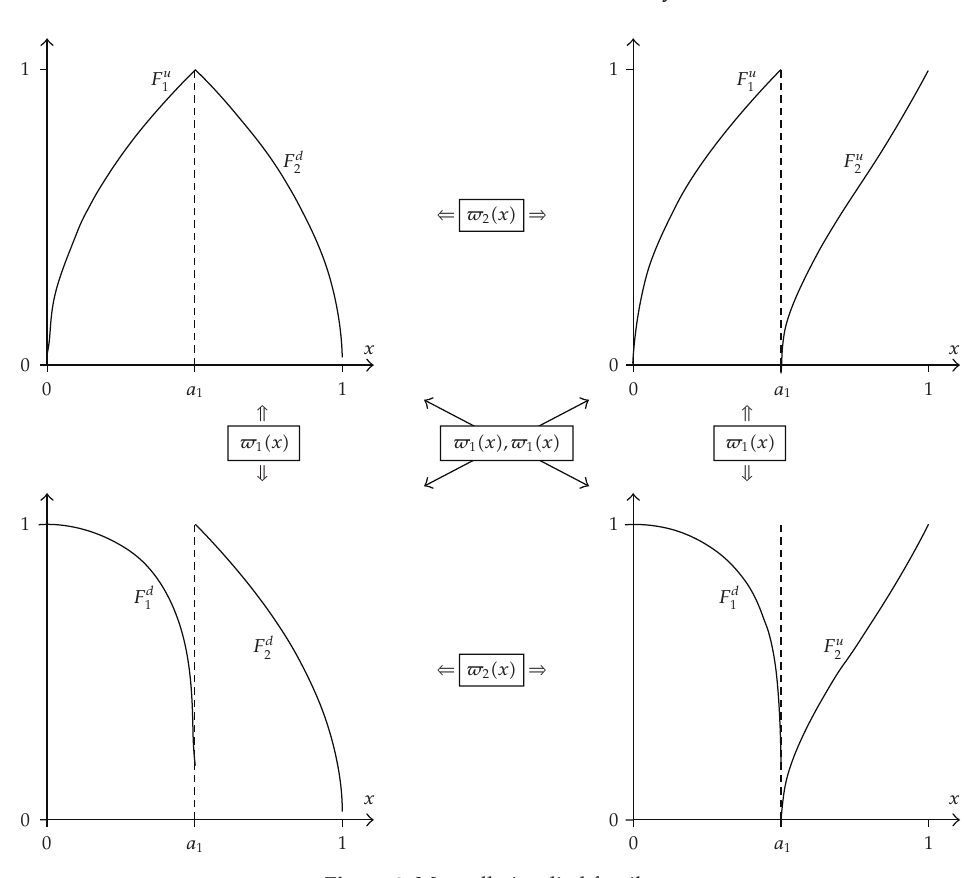
Figure 2: Mutually implied